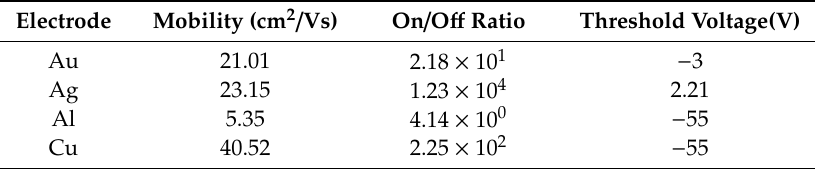
Table 1. Characteristic data of the MoS 2 -FET devices (V DS = 10 V).